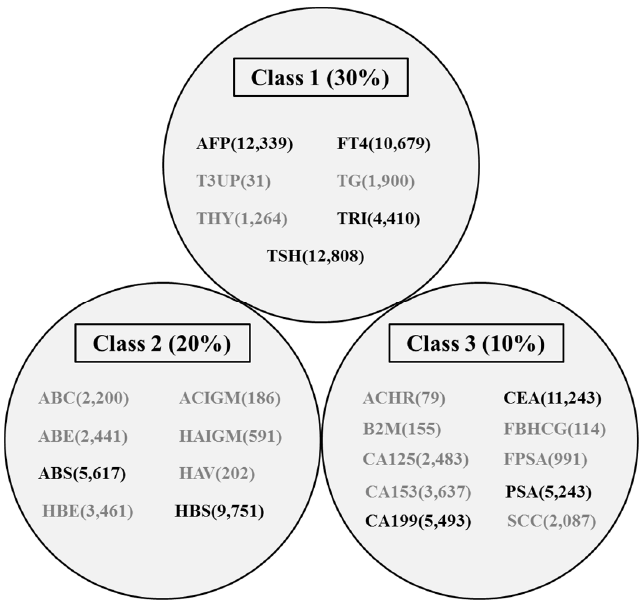
Figure 5. Support threshold value of stand-alone operation.